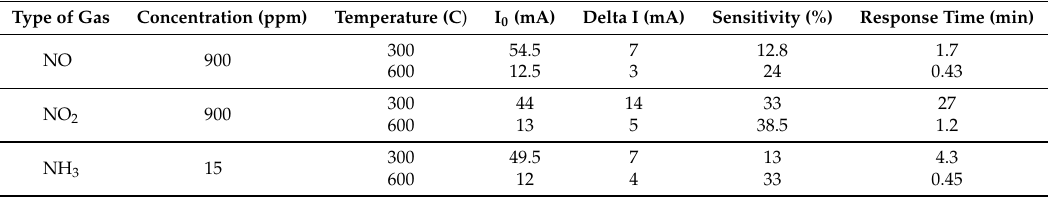
Table 1. Pt-AlGaN/GaN HEMT sensor performances as a function of the operation temperature at V ds = 5